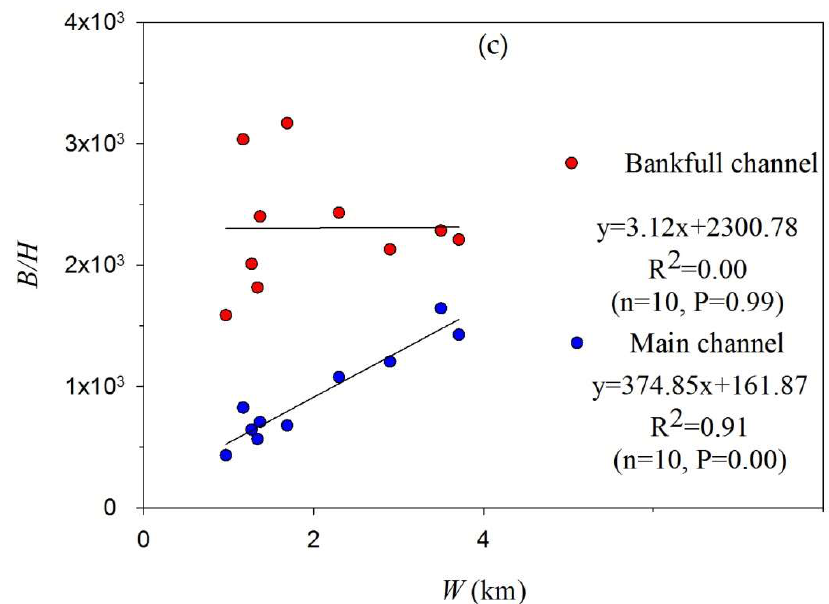
Figure 14. Relationships of wandering belt width ( W ) with main channel geometries: ( a ) width of the bankfull or main channel ( B ); ( b ) average depth of the bankfull or main channel ( H ), and ( c ) width/depth ratio of the bankfull or main channel. Note: (1) All widths, average depths, and width/depth ratios are computed from the eight measured cross-profiles along the study reach; (2) The eight cross-profiles are located at Qinchang, Huayuankou, Babu, Laitongzhai, Xinzhai, Weicheng, Liuyuankou, and Caogang, respectively.